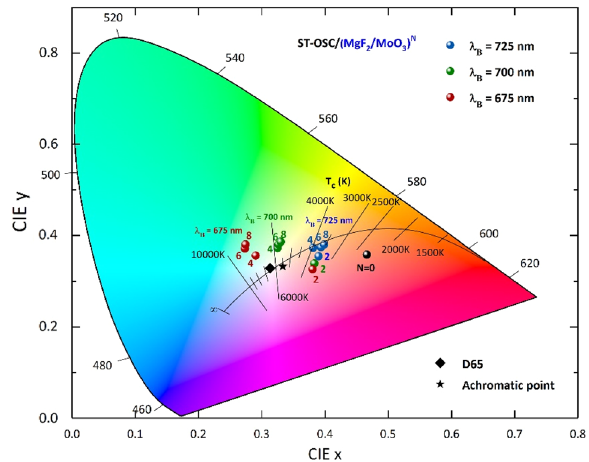
Figure 2. Variation of color coordinates in a semi-transparent organic solar cell. CIE 1931 chromaticity diagram presents the variation of color coordinates for λ B = 675, 700, 725 nm according to the period number of 1D-PC in ST-OSC/(MgF 2 /MoO 3 ) N . The black line represents the Planckian locus for different color temperatures. The black spherical symbol represents the color coordinate of ST-OSC at N = 0, the black square and star symbolize the D65 and achromatic point locations,